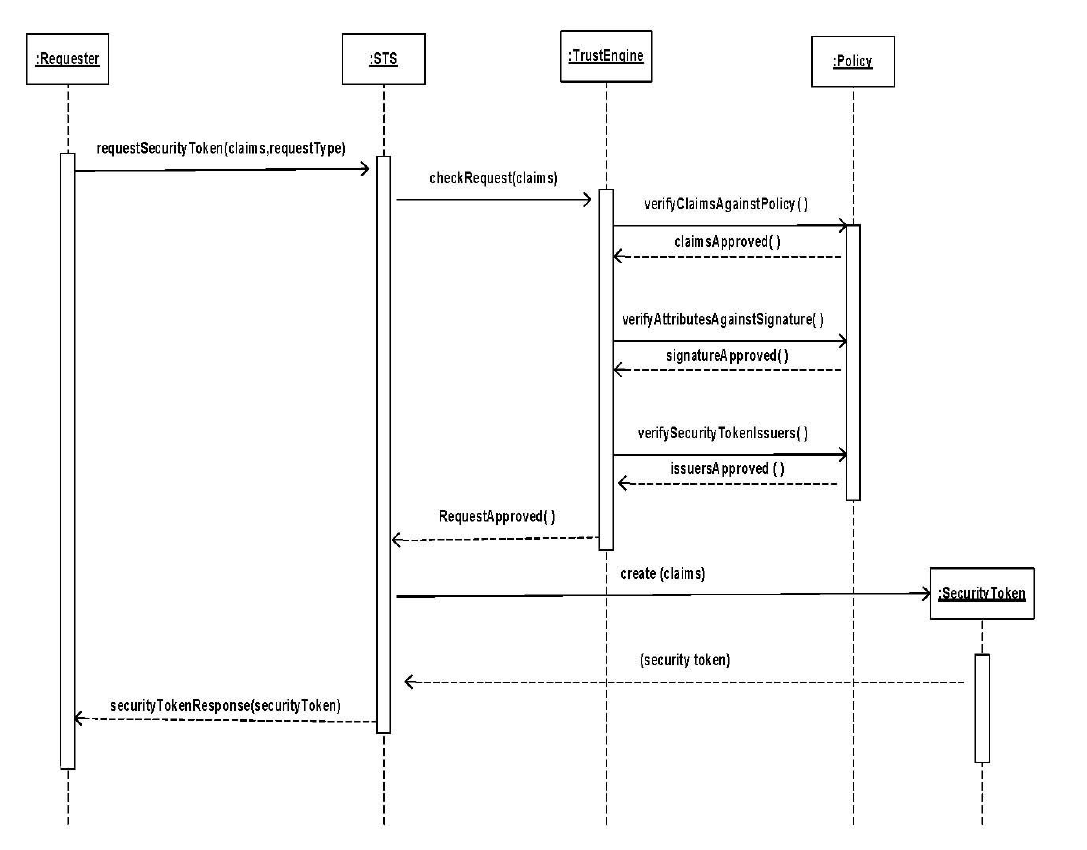
Figure 6. Sequence Diagram creating a security